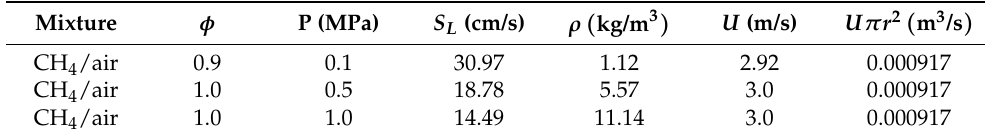
Table 1. Parameters of the CH 4 /air mixtures at different pressures. Mixture